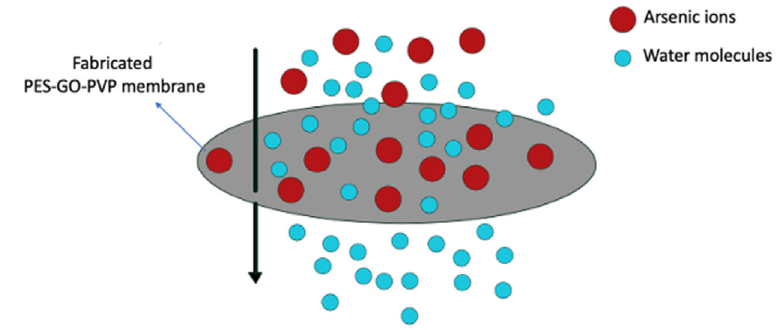
Fig. 8. Schematic representation of arsenic removal through PES-GO-PVP membrane adsorption. Adapted from